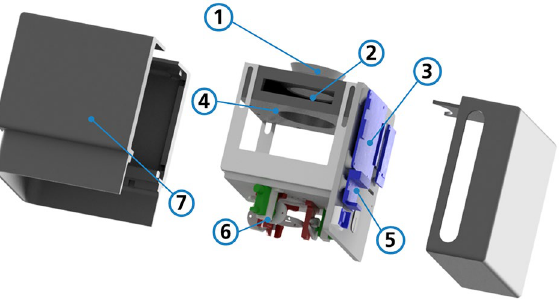
Figure 4. Optical components adapter. (1) Microscope mounting (2) LCD holder (3) LCD driver (4) Condenser lens mount (5) Motor driver (6) Adaptable prism (7) Housing. The light enters the adapter from the microscope mounting and leaves it after the adaptable